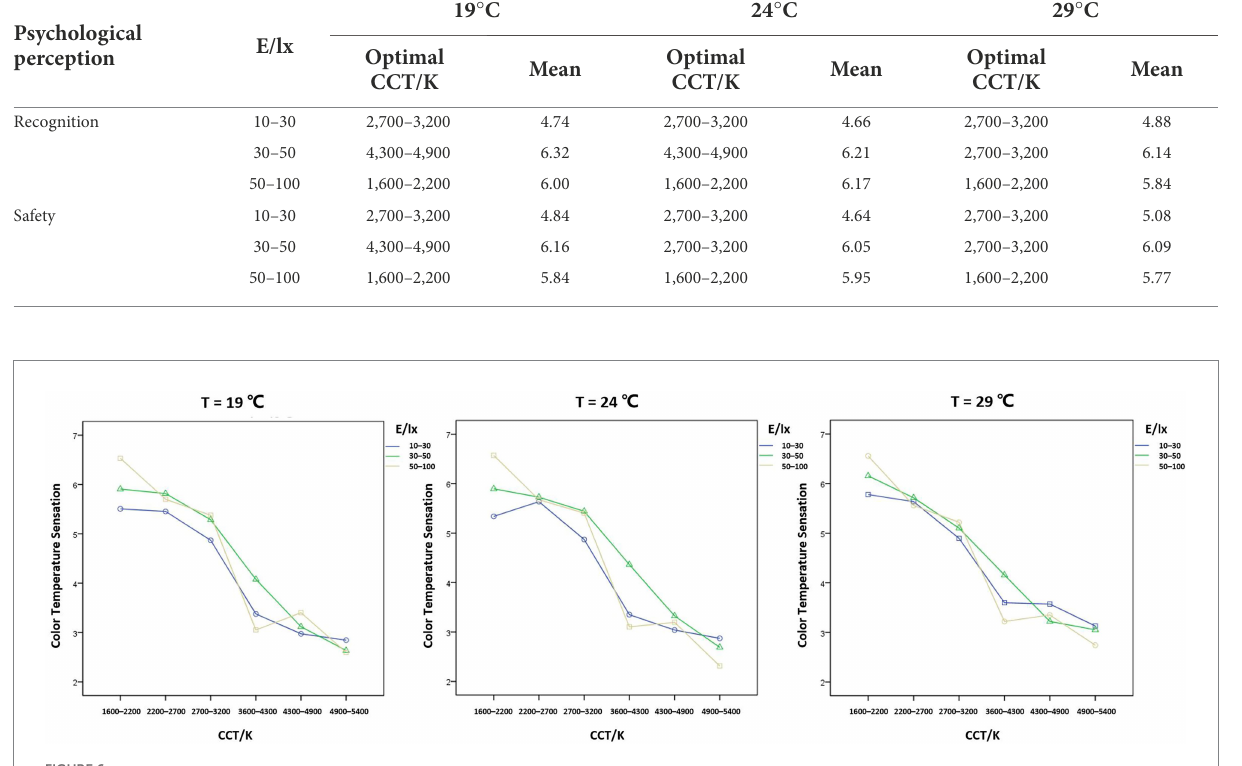
FIGURE 6 Interaction trend of CCT, illuminance, and experimental temperature on the color temperature sensation score.